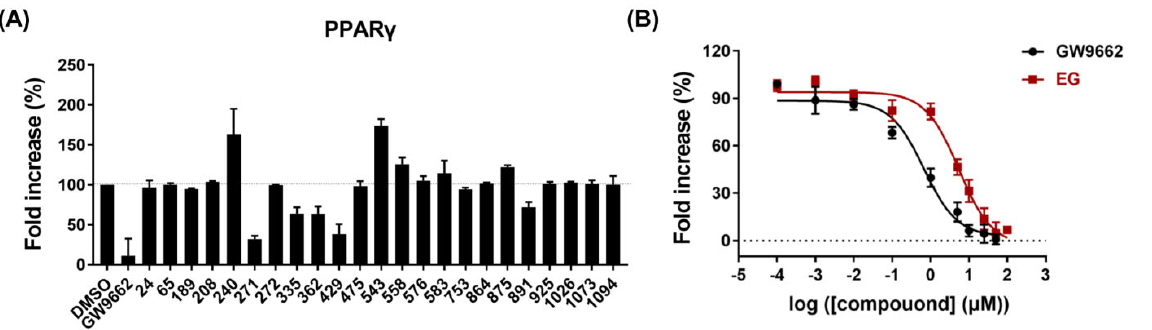
Figure 4. Identification of PPAR γ antagonistic effect of ethyl gallate (EG). After a 6 h co-transfection with pCMV6-hPPARG-GFP and pPPRE-TK-luc, CHO cells were treated with compounds in the presence of 2 μ M rosiglitazone and incubated for 24 h. ( A ) PPAR γ antagonistic activities against hit compounds, exhibiting PTPN6 inhibition. Cells were treated with each compound at 20 µ M concen- tration. The compound names corresponding to the compound numbers are listed in Table S1. Data are shown as mean ± standard deviation ( n = 2). ( B ) Concentration-dependent PPAR γ antagonistic activities of EG. Cells were treated with EG or GWW9662 at various concentrations (0.0001, 0.001, 0.01, 0.1, 1, 5, 10, 25, 50, and 100 μ M). The IC 50 values represent the concentrations of compounds that inhibited 50% of the response induced by 2 µ M rosiglitazone. Data are shown as mean ± standard deviation ( n = 3).